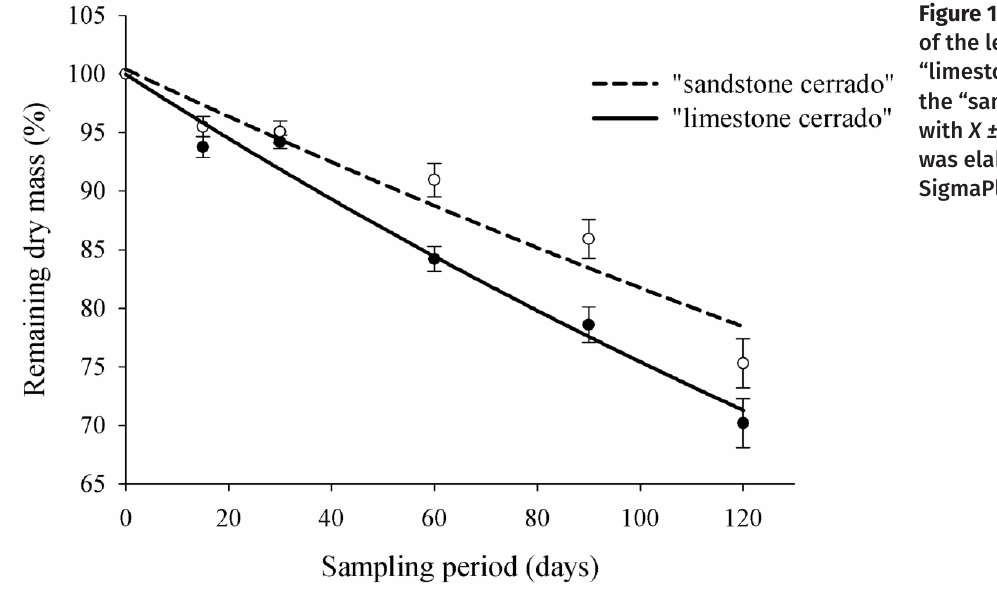
Figure 1. Decomposition of the leaves in the “limestone cerrado” and the “sandstone cerrado” with X ± EP. This figure was elaborated in the SigmaPlot (version